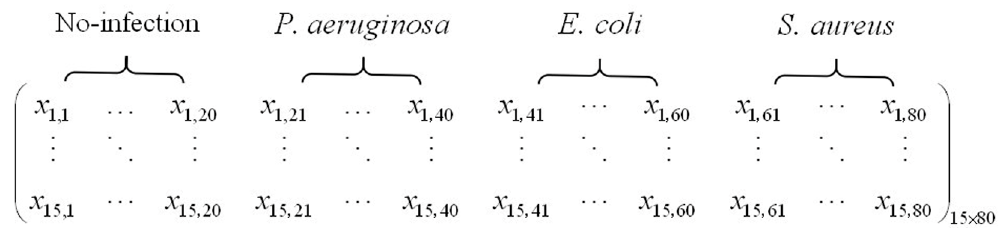
Figure 5. Detailed information of this original feature matrix.